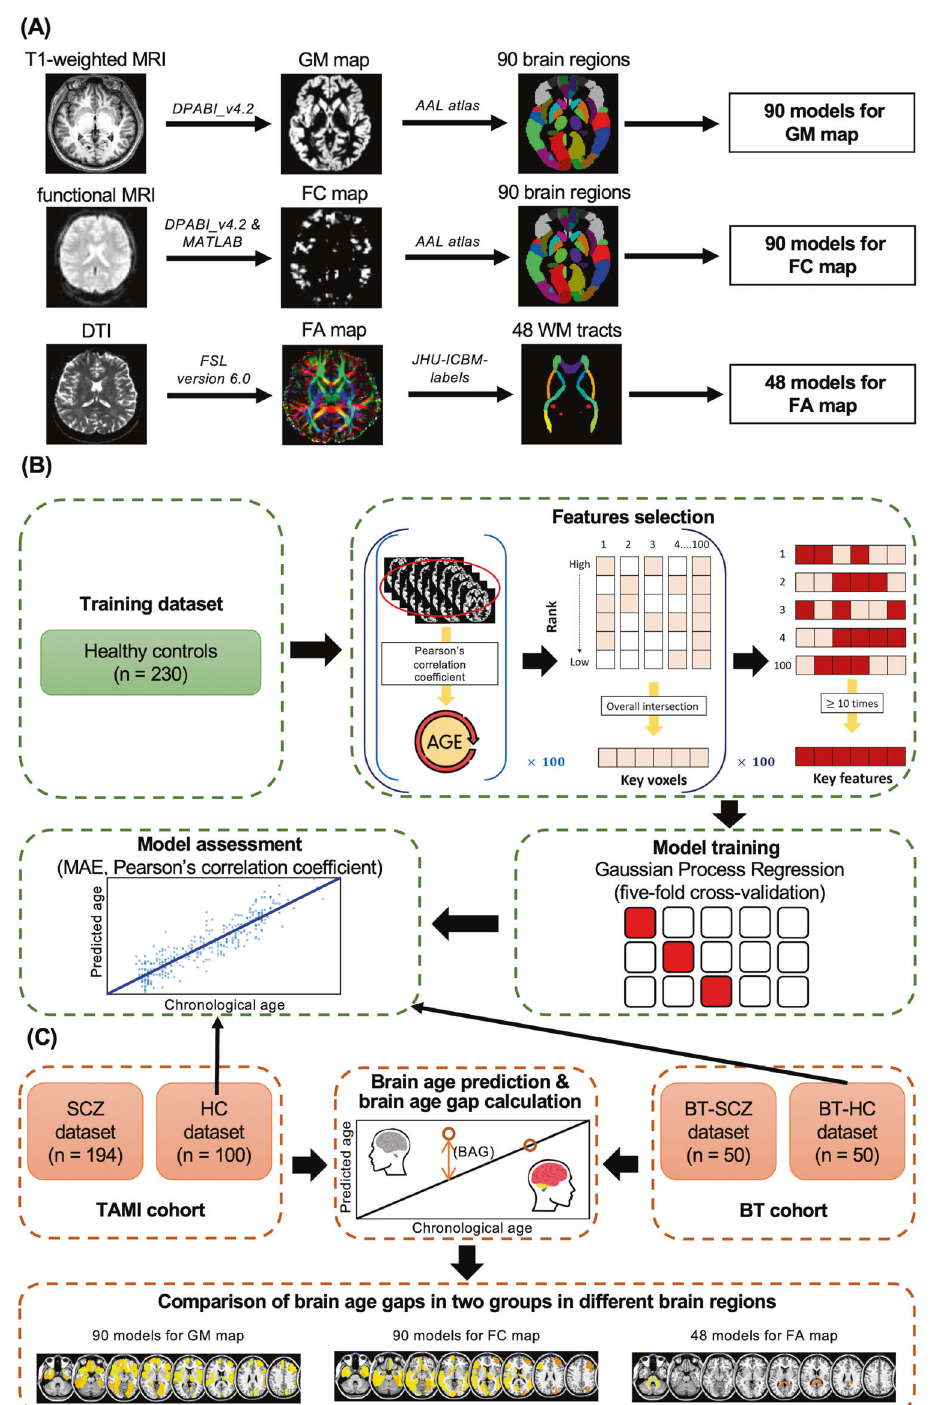
Fig. 1 Flow of data processing and brain-age prediction model construction. A Illustration of neuroimaging preprocessing steps for T1- weighted MRI, fMRI, and DTI. After data preprocessing, we obtained 90 GM, 90 FC, and 48 FA maps for subsequent analysis. B After extracting voxels highly correlated with chronological age for each map as features, we used the Gaussian process regression algorithm to train 228 brain-age prediction models and calculated the MAEs and Pearson ’ s correlation coef fi cient between corrected brain ages and chronological ages to evaluate our models ’ performance. The HC and BT-HC datasets were also used to examine the reproducibility of our brain-age prediction models. C The trained models were applied to the HC, SCZ, BT-HC, and BT-SCZ datasets to estimate brain ages and calculate brain- age gaps. Finally, ANCOVA was used to examine the differences in brain age gaps between participants with schizophrenia and HCs for different brain regions in the TAMI and BT cohorts, respectively. DTI diffusion tensor imaging, GM gray matter, WM white matter, FC functional connectivity, FA fractional anisotropy, AAL automated anatomical labeling, MAE mean absolute error, SCZ individuals with schizophrenia, HCs healthy controls, BAG brain age gap, TAMI Taiwan Aging and Mental Illness, BT Tri-Service General Hospital Beitou Branch.